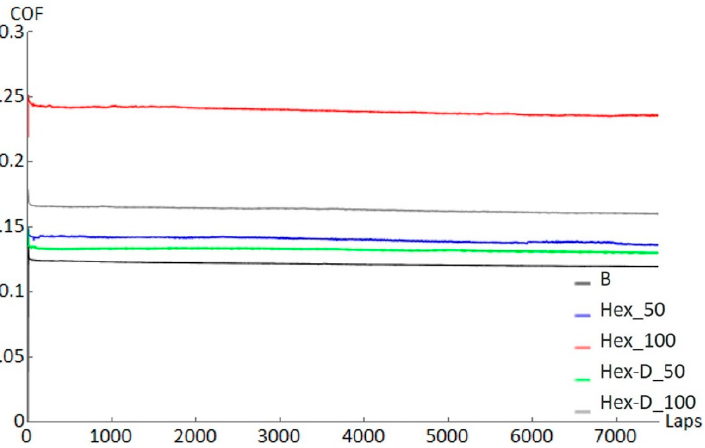
Figure 11. Coefficient of friction for lubricated tests at a sliding radius of 13.5 mm and normal load 5 N (R13.5_N5_L).